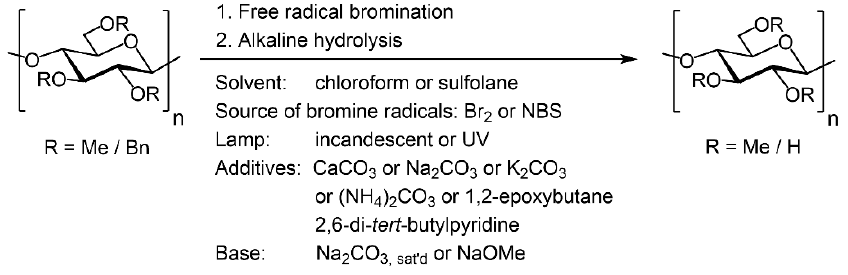
Scheme 3. Summary of investigated reaction parameters for debenzylation of